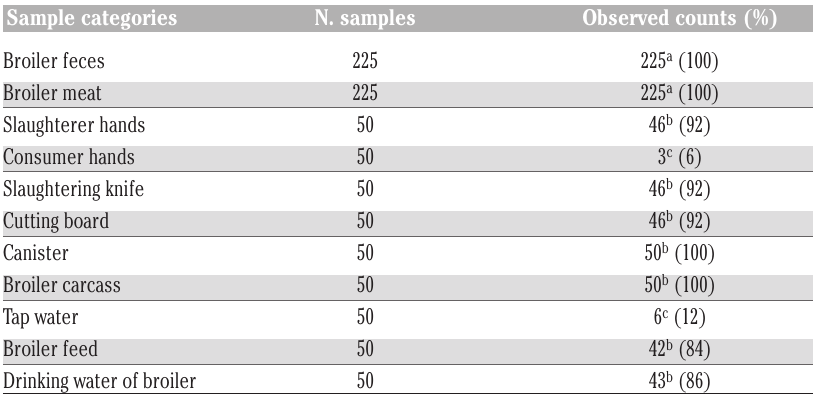
Table 1. Prevalence of E . coli in different categories of samples taken from poultry shops in